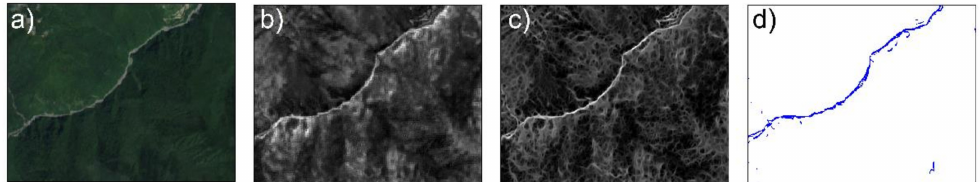
Figure 9. ASRM results in the presence of mountain shadow. ( a ) Original Sentinel-2 image. RGB: band 4 (Red), band 3 (Green), band 2 (Blue). ( b ) MNDWI image. ( c ) Gabor filtered MNDWI image. ( d ) ASRM